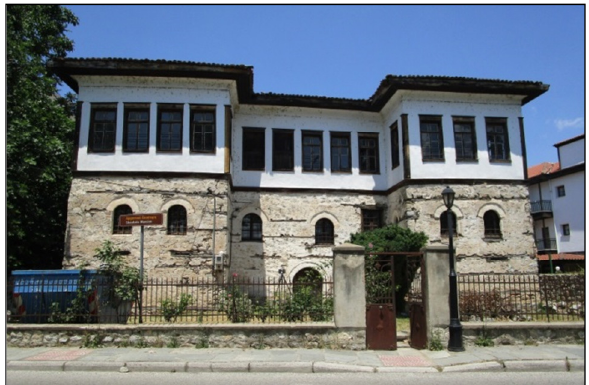
Figure 2. Skoutaris Mansion (image taken by the author).